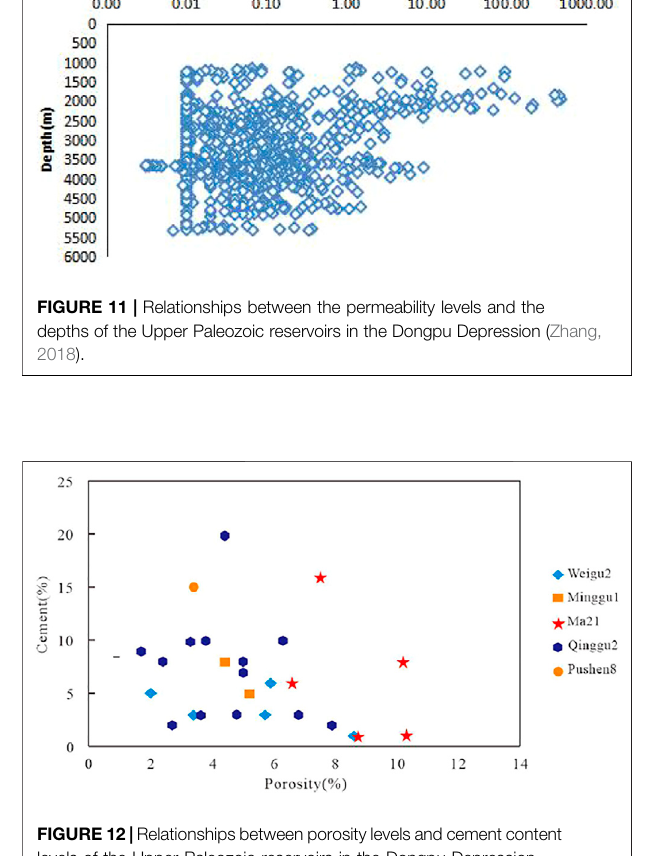
Frontiers in Earth Science |